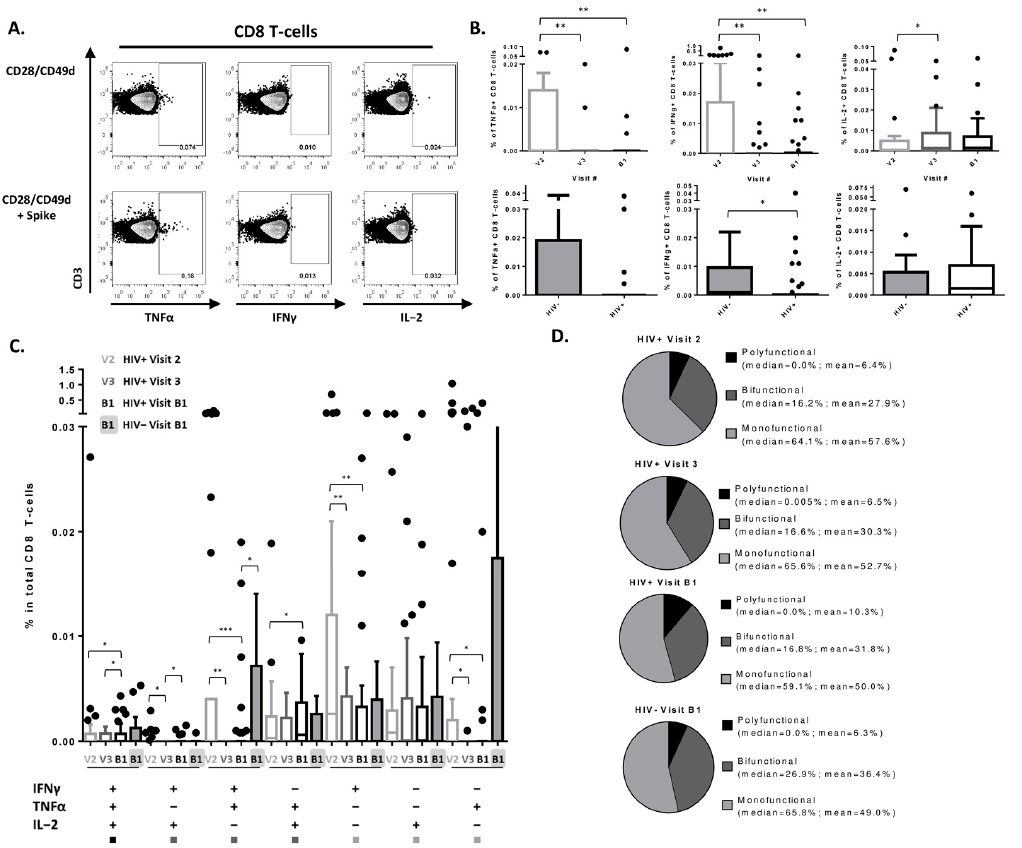
Figure 3. SARS-CoV-2-specific CD8 T-cell response. ( A ) Examples of flow cytometry plots of live CD8 T-cells with gates on TNF α +, IFN γ +, and IL-2+ cells from left to right, respectively. Signal detected in “CD28/CD49d” was subtracted from “CD28/CD49d + Spike” for all samples. ( B ) Frequencies of TNF α +, IFN γ +, and IL-2+ CD8 T-cells post 1st, 2nd, and 3d vaccine doses in PLWH (top row) and post 3d vaccine dose in PLWH versus seronegative controls with (bottom row). Lines in HIV+ versus HIV- plots indicated the median and interquartile range. ( C ) Frequencies of cytokine producing SARS-CoV-2-specific CD8 T-cells in total CD8 T-cell pool at different time points in PLWH and uninfected controls. Squares at the bottom of the graph indicate whether the cell subset was classified as polyfunctional, bifunctional, or monofunctional when graphing the pie chart on Figure 2D. ( D ) Proportions of polyfunctional, bifunctional, and monofunctional cells within SARS-CoV-2-specific CD8 T-cells at different time points in PLWH and uninfected controls. Median frequencies of each subset in SARS-CoV-2-specific CD8 T-cells are indicated to the right of each pie chart. Pie charts were generated using the mean values. Comparisons were made using Wilcoxon-Pratt signed rank test for paired variables and Mann–Whitney for unpaired variables (* p < 0.05, ** p < 0.01, *** p < 0.001). Study visits: V1—pre-vaccination baseline, V2—1 month post 1st dose, V3—3 months post 2nd dose, B1—1 month post 3rd dose.